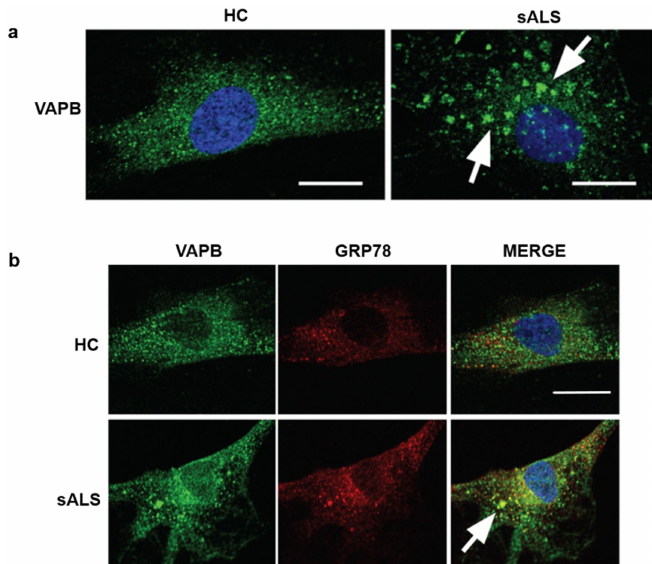
Figure 4. ( a ) Representative immunofluorescence image of primary skin fibroblasts performed with an antihuman VAPB polyclonal antibody. VAPB (green) and nuclei (blue) in fibroblasts were isolated from HCs (left) and sALS patients (right). The sALS patient fibroblasts staining showed globular accumulations of VAPB (indicated by arrows) compared to the control. ( b ) Image showing single staining of VAPB (green) (left), GRP78 (red) (middle), and merge (right). The merge evidenced the colocalization of GRP-78 with the VAPB accumulations (indicated by arrows) representing the ER distribution. Scale bars: 15 µ